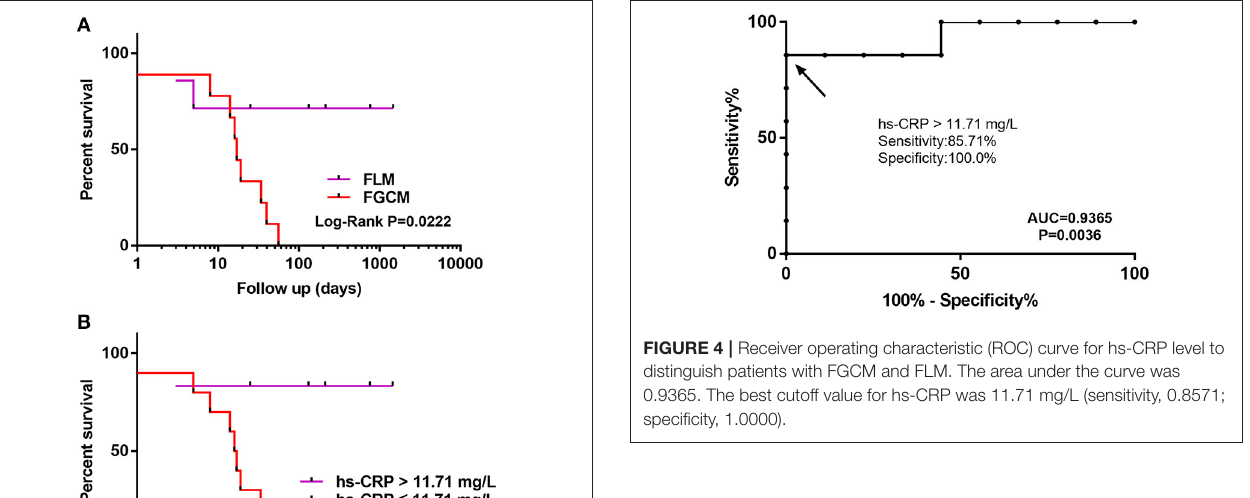
With an optimal cutoff value of 11.71 mg/L for the levels